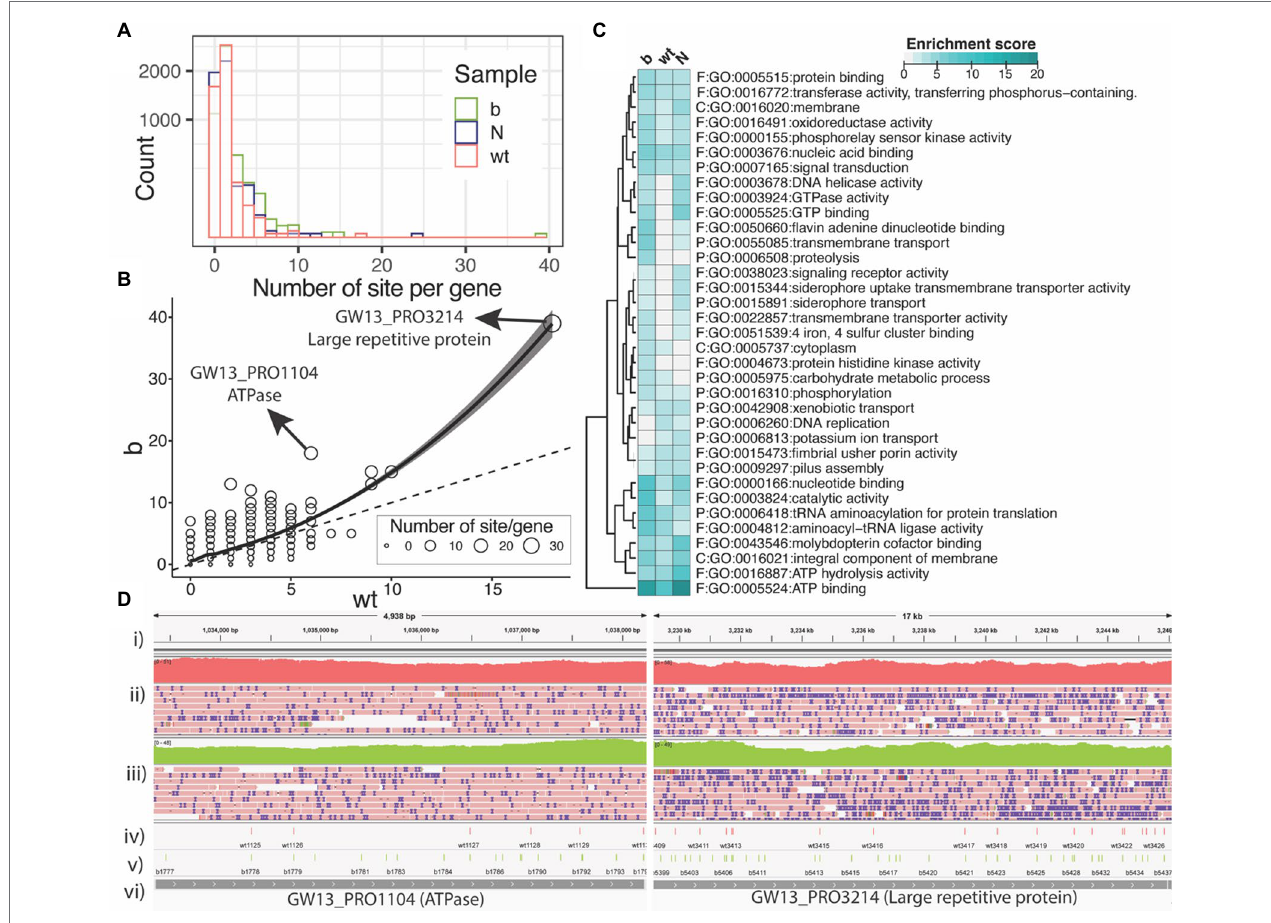
FIGURE 4 | PT modification sites within the Salmonella enterica genome. (A) Number of PT modification sites per gene (square root y -axis) in the three samples of wild type (wt), ∆ dndB (B) , and the Nick-seq data (N). (B) Number of PT modification sites per gene for the wild-type strain vs. ∆ dndB strain. (C) List of genes with the most PT modification sites per strain. (D) Integrative Genomics Viewer images for ATPase and Large repetitive protein genes; (i) reference genome, (ii) wild-type gene coverage and reads, (iii) ∆ dndB gene coverage and reads, (iv) wild-type PT modifications, (v) ∆ dndB PT modifications, and (vi) gene